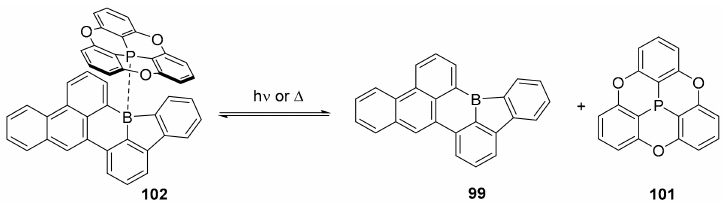
Scheme 26. Formation of complex 102 and its behavior upon heating or